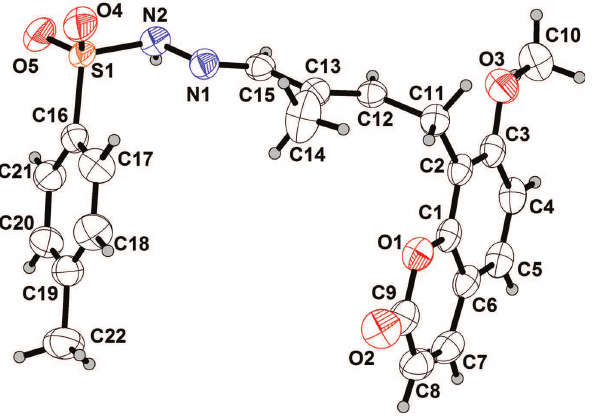
Table 2: Fractional atomic coordinates and isotropic or equivalent isotropic displacement parameters (Å 2